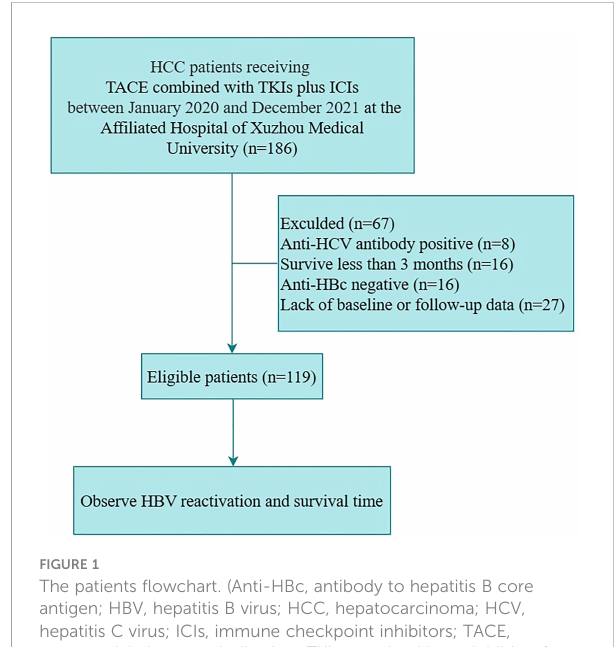
FIGURE 1 The patients fl owchart. (Anti-HBc, antibody to hepatitis B core antigen; HBV, hepatitis B virus; HCC, hepatocarcinoma; HCV, hepatitis C virus; ICIs, immune checkpoint inhibitors; TACE, transarterial chemoembolization; TKIs, tyrosine kinase